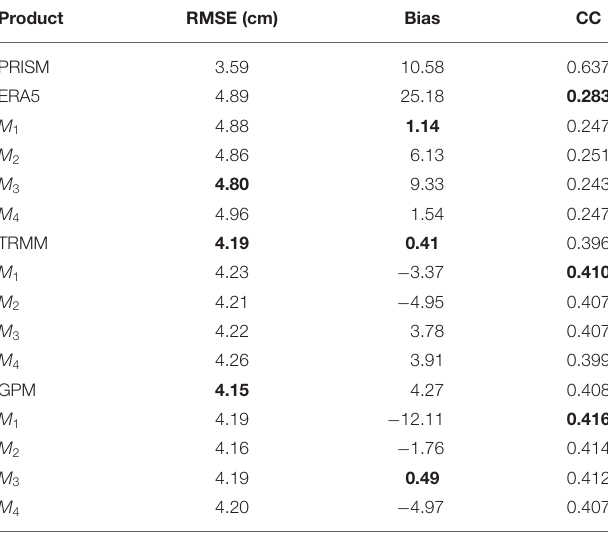
TABLE 2 | Summary of gauge comparison metrics on testing data (2017/01–2018/12) for three precipitation products, ERA5, TRMM, and GPM, and AU-Net models (best performing member in each category is